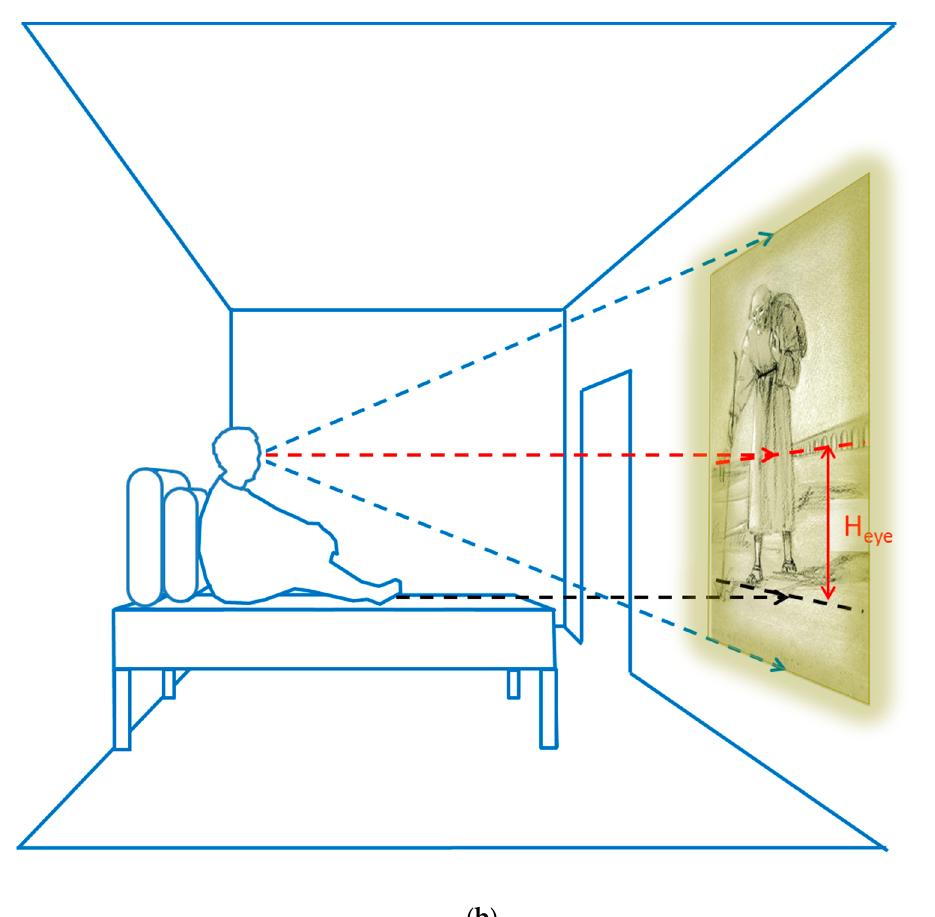
Figure 5. ( a ) (Upper panel): Peter’s portrait drawn by L. Ferri, under Maria Valtorta’s guidance, in which Peter is walking on the rural road, between the two Roman consular roads (Via Tiburtina and Via Nomentana). He moves North-East, with an aqueduct visible behind him, directed almost orthogonally to his walking path [11], p. 12. ( b ) (Lower panel): Sketch of Maria Valtorta’s bedroom, while she is “seeing” Peter going from the via Tiburtina to via Nomentana, along the rural road, as it can be evinced by the perspective analysis of the L. Ferri’s drawing.